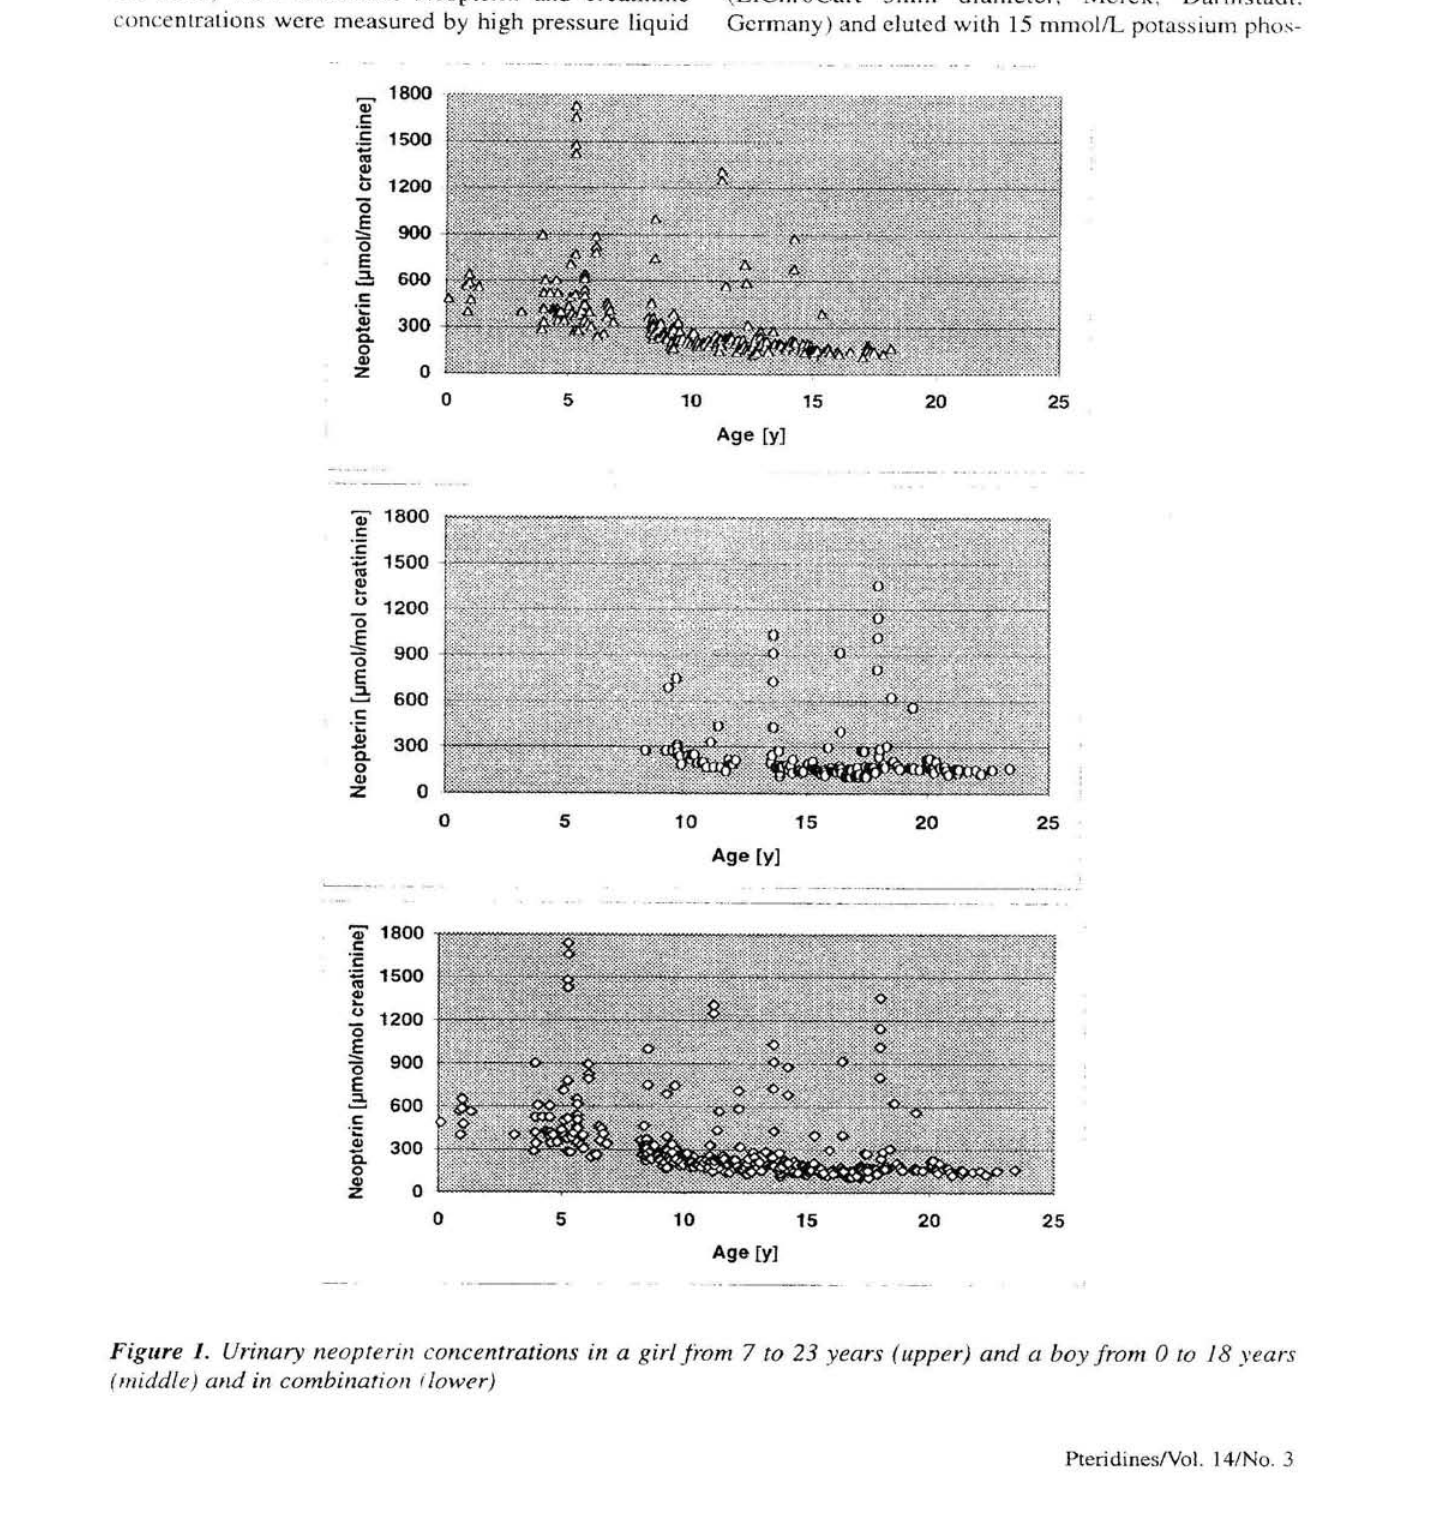
Figure 1. Urinary neopterin concentrations in a girl from 7 to 23 years (upper) and a boy from 0 to 18 years (middle) and in combination ι lower)